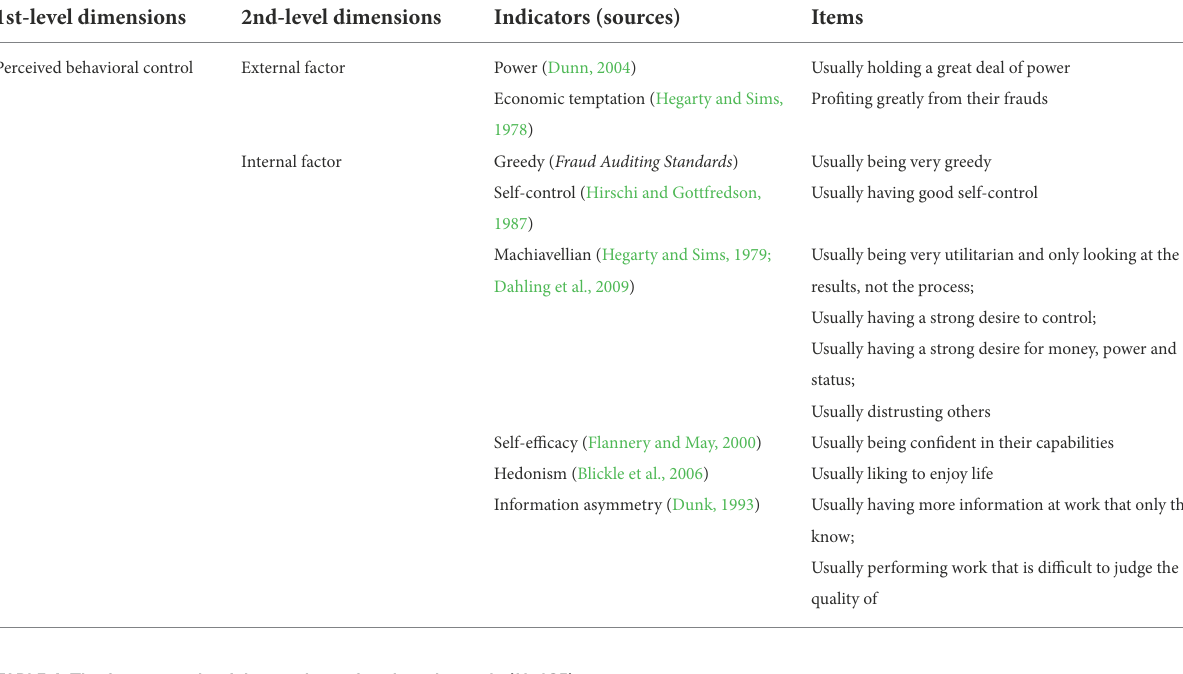
TABLE 4 The factor matrix of the employee fraud motive scale ( N =